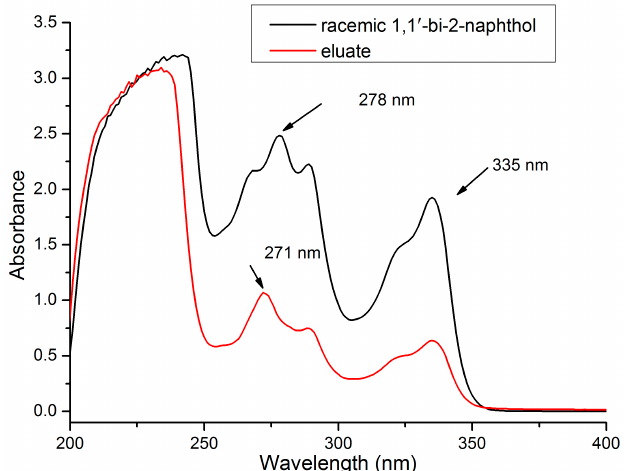
Figure 3. UV-visible spectra of racemic (±)-1,1 ′ -bi-2-naphthol and eluate.